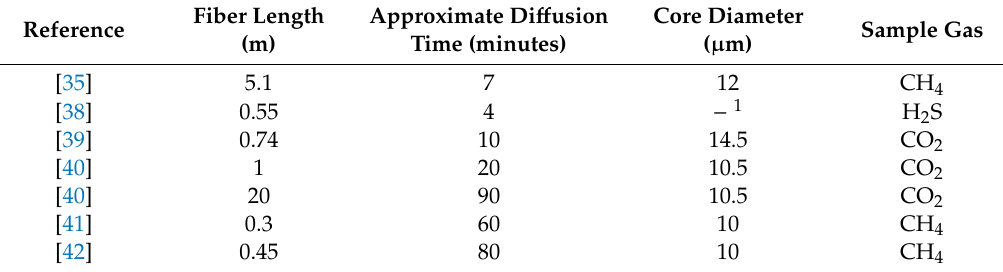
Table 1. Filling times measured in various systems with photonic band-gap (PBG) HCFs.